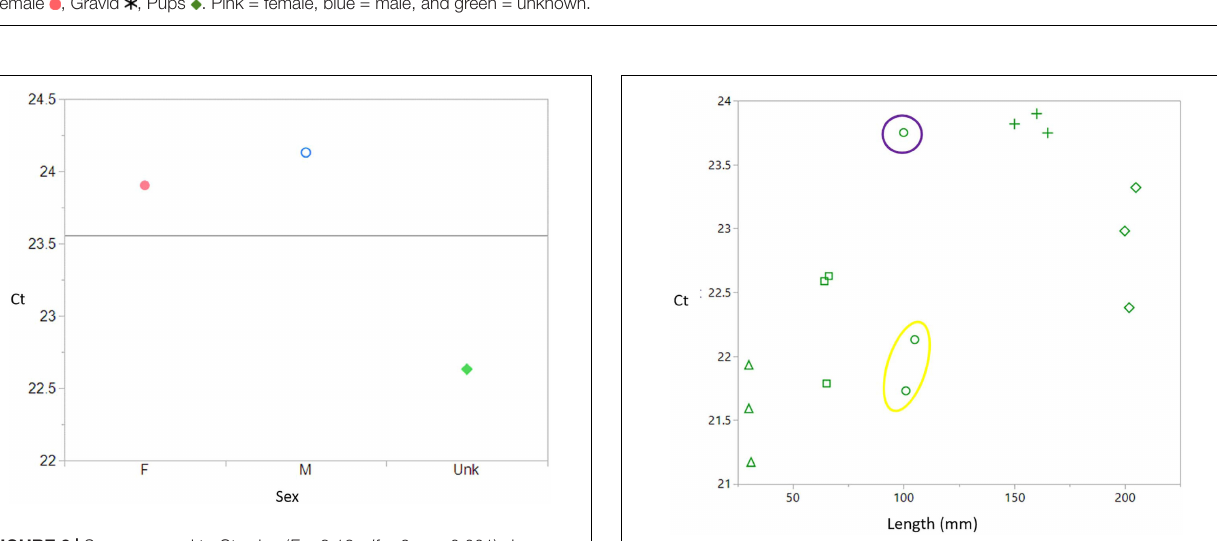
FIGURE 2 | Sex compared to Ct value ( F = 8.18, df = 2, p = 0.001) shows a significant relationship. A post-hoc Student’s t, showed that the means between Females (23.90) and Males (24.13) were not significantly different from one another ( p = 0.60), but both are significantly different from the unknown Pups (22.63) (M to Unk p = 0.001; F to Unk p = 0.002). Male , Female , Pups . Pink = female, blue = male, and green = unknown.